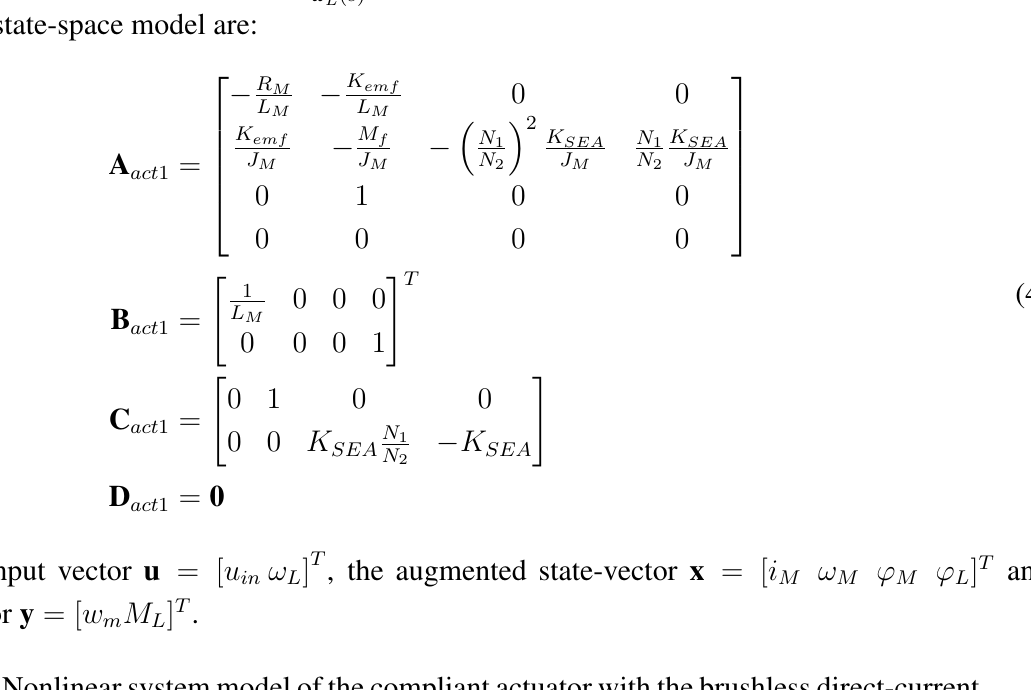
ϕ ] T ; and output: in L